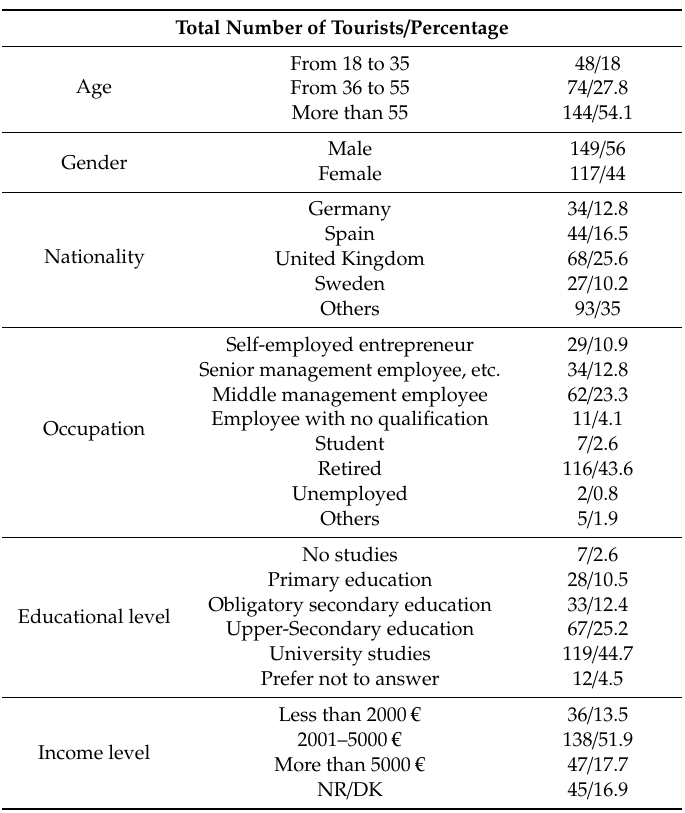
Table 2. Tourists’